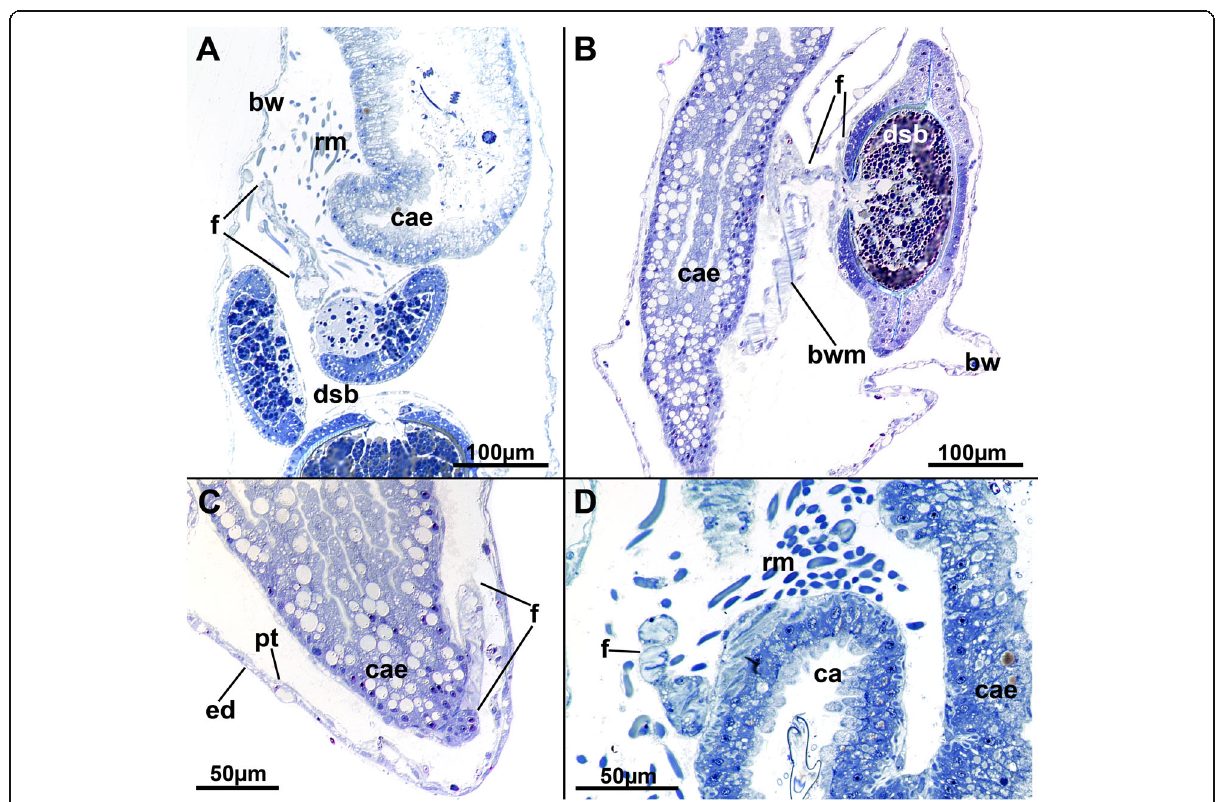
Fig. 13 Histological details of the funiculus of Stephanella hina . All longitudinal sections. a Funiculus in close proximity to the caecum and several developing statoblasts, which are also covered by a thin lining of funicular epithelium. b A funicular strand that encloses a very progressed statoblast anlage. The funicular lining surrounding the latter is very thin. c Proximal end of the caecum showing the origin of the funiculus. d Close-up of a funicular strand, which consists of a thin epithelium surrounding a small central lumen. Abbreviations: bw - body wall, bwm - body wall musculature, ca - cardia, cae - caecum, dsb - developing statoblast, ed. - epidermis, f - funiculus, pt. - peritoneum, rm. - retractor